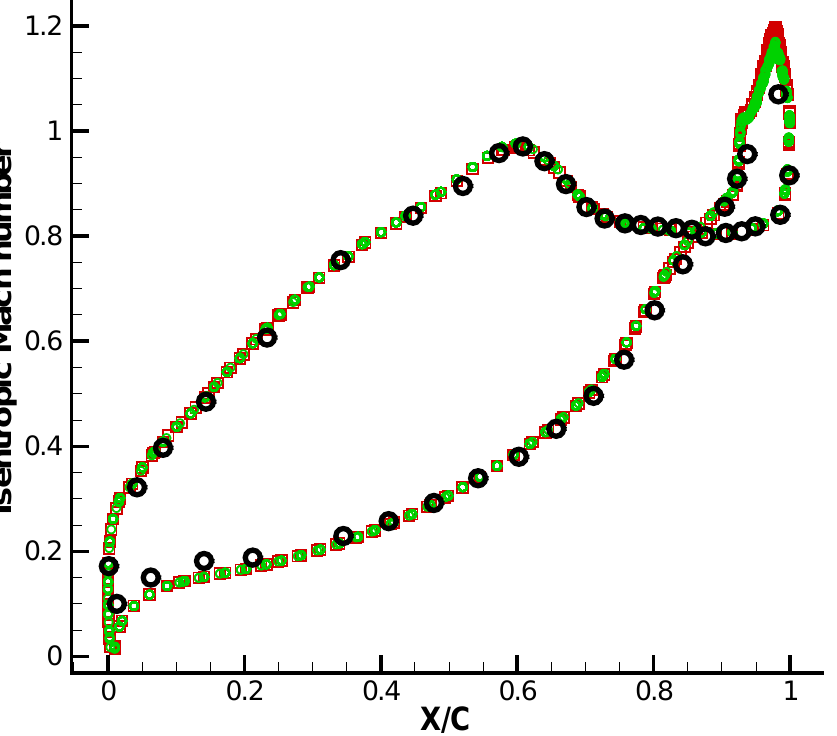
Figure 12. Time and spanwise-averaged isentropic Mach number distribution along blade. Black circle, experimental data of Sieverding et al. [49]; red squares, obtained results using CBC; green circles, obtained results using